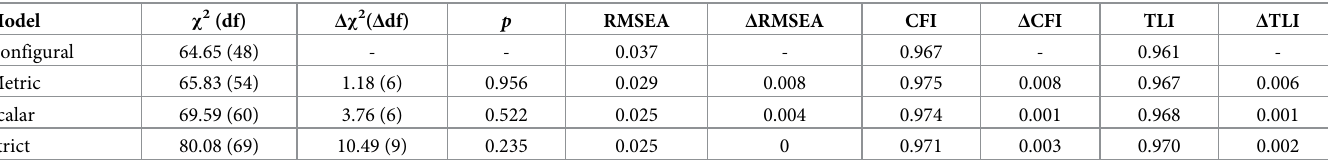
Table 3. Measurement invariance by